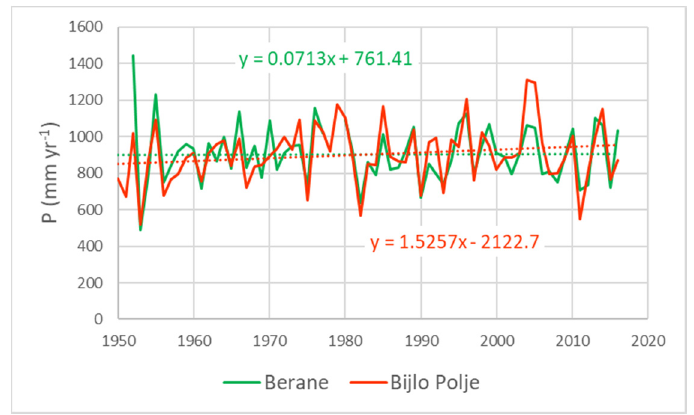
Figure 3. Long term variability of annual precipitation in the study area.